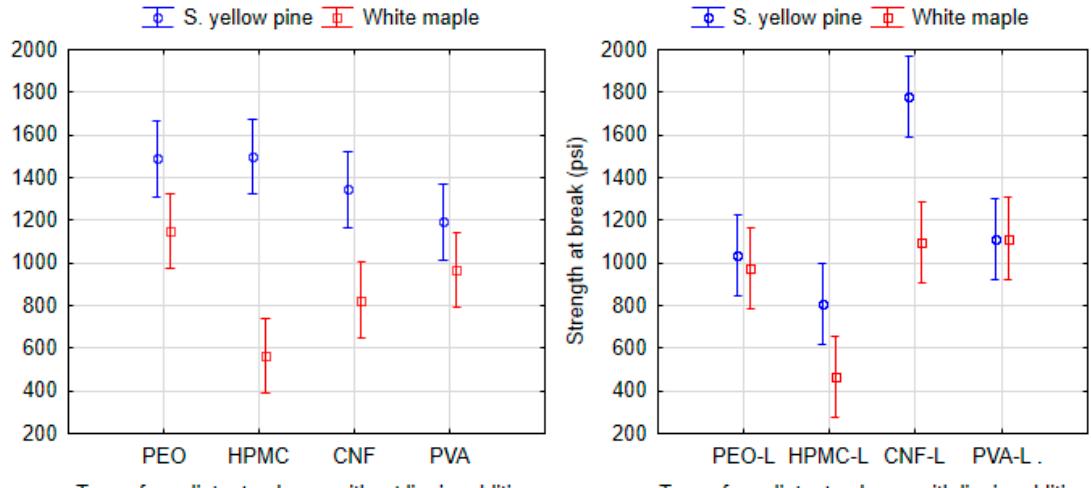
Figure 7. ANOVA of the dry shear strength at the break point and the effect between 9% and 10% total solid on the adhesives with SPI, PEO and lignin variation. Vertical bars denote 95% confidence interval.